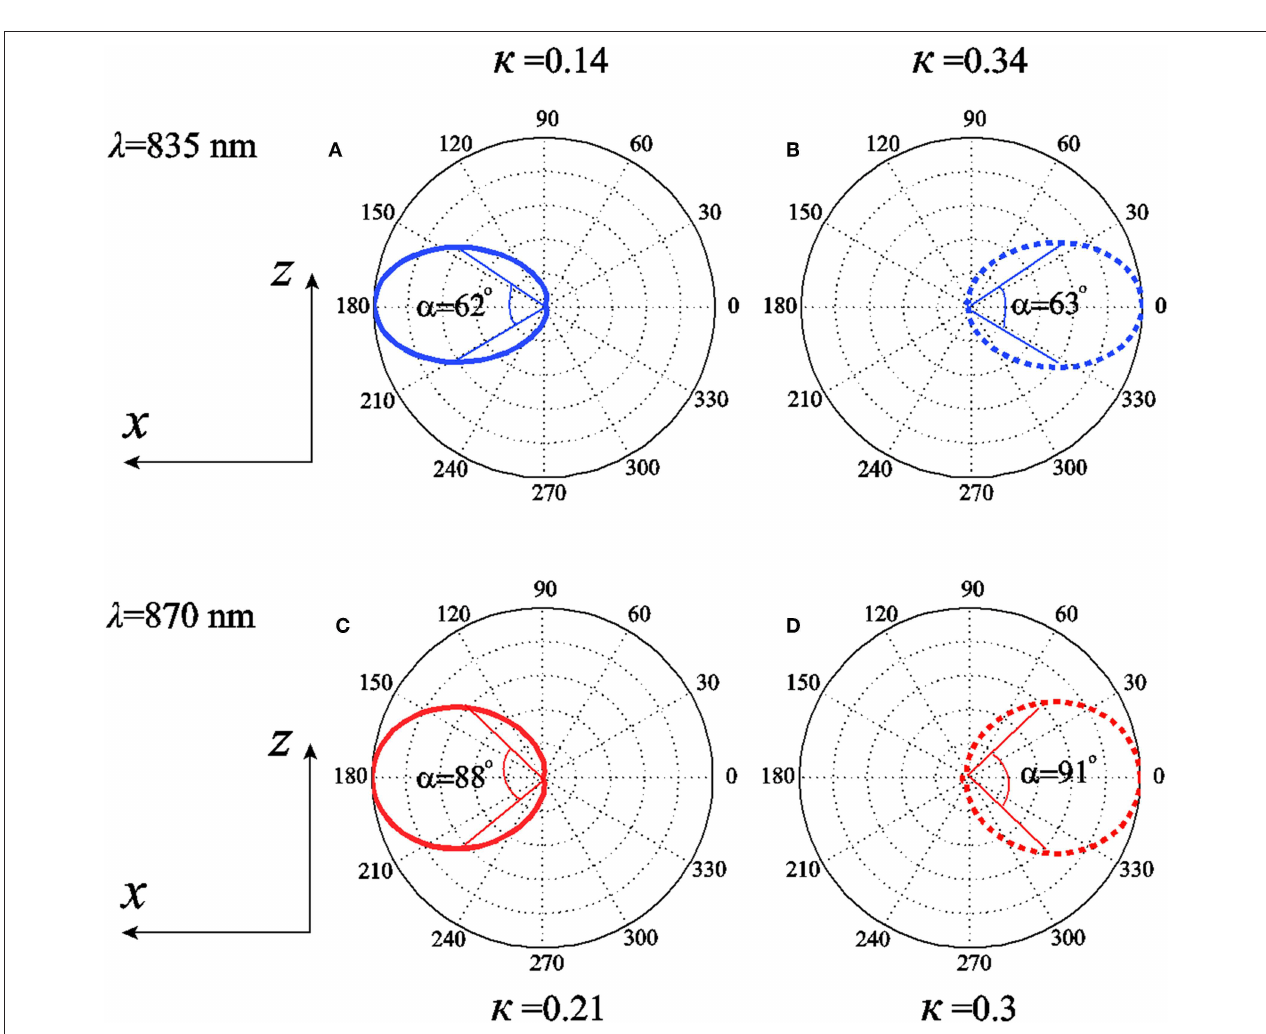
FIGURE 6 | 2D radiation patterns in the xoz plane. (A,B) Scattering pattern with κ = 0.14 and κ = 0.34 at λ = 835nm, respectively. (C,D) Scattering pattern with κ = 0.21 and κ = 0.3 at λ = 870nm, respectively.